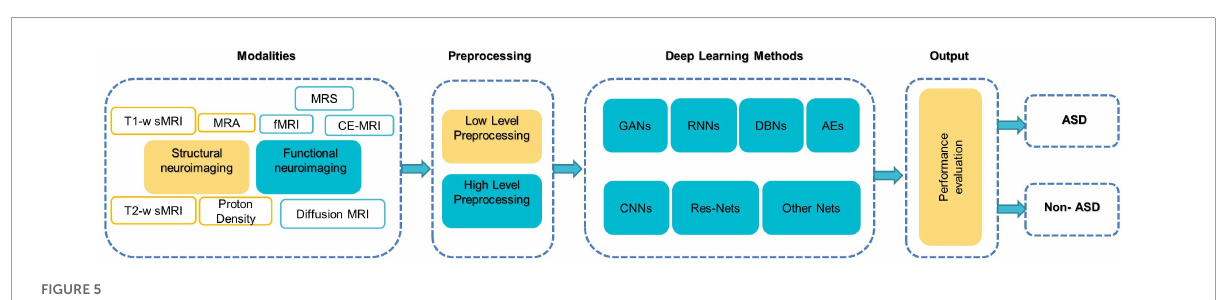
FIGURE4 Differences between (A) ML-based studies workflow and (B) DL-based studies workflow.